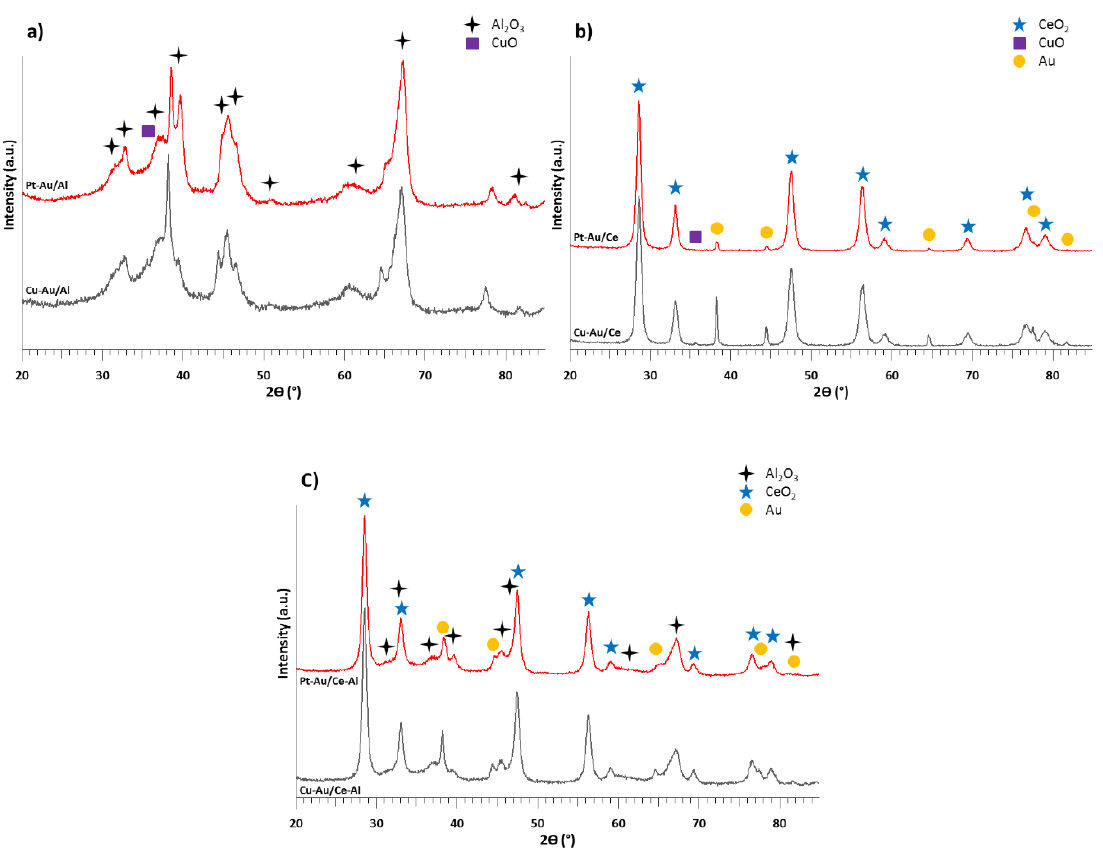
Figure 1. XRD di ff ractograms of ( a ) Pt–Au and Cu–Au on γ -Al 2 O 3 , ( b ) Pt–Au and Cu–Au on CeO 2 , Figure 1. XRD diffractograms of ( a ) Pt – Au and Cu –Au on γ -Al 2 O 3 , ( b ) Pt – Au and Cu – Au on CeO 2 , and ( c ) Pt–Au and Cu–Au on CeO 2 –Al 2 O 3 and ( c ) Pt – Au and Cu – Au on CeO 2 – Al 2 O 3 supports.